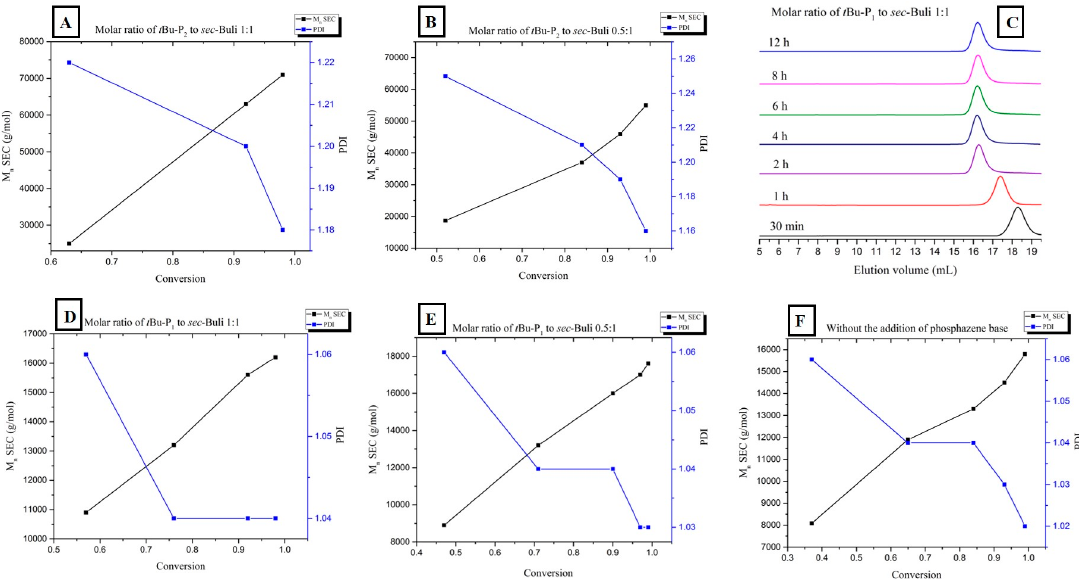
Figure 3. ( A , B ) Relationship between number-average molecular weight (black line) and polydispersity (blue line) vs. monomer conversion during the 1:1 and 0.5:1 [ t -BuP 2 ]/[ sec -BuLi] polymerization of styrene; ( C ) SEC traces obtained from withdrawn aliquots at different time intervals during the [ t -BuP 1 ]/[ sec -BuLi]: 1:1 polymerization of styrene; ( D , E ) Relationship between number-average molecular weight (black line) and polydispersity (blue line) vs. monomer conversion during the 1:1 and 0.5:1 [ t -BuP 1 ]/[ sec -BuLi] polymerization of styrene; ( F ) Relationship between number-average molecular weight (black line) and polydispersity (blue line) vs. monomer conversion during the polymerization of styrene in the absence of phosphazene superbase.